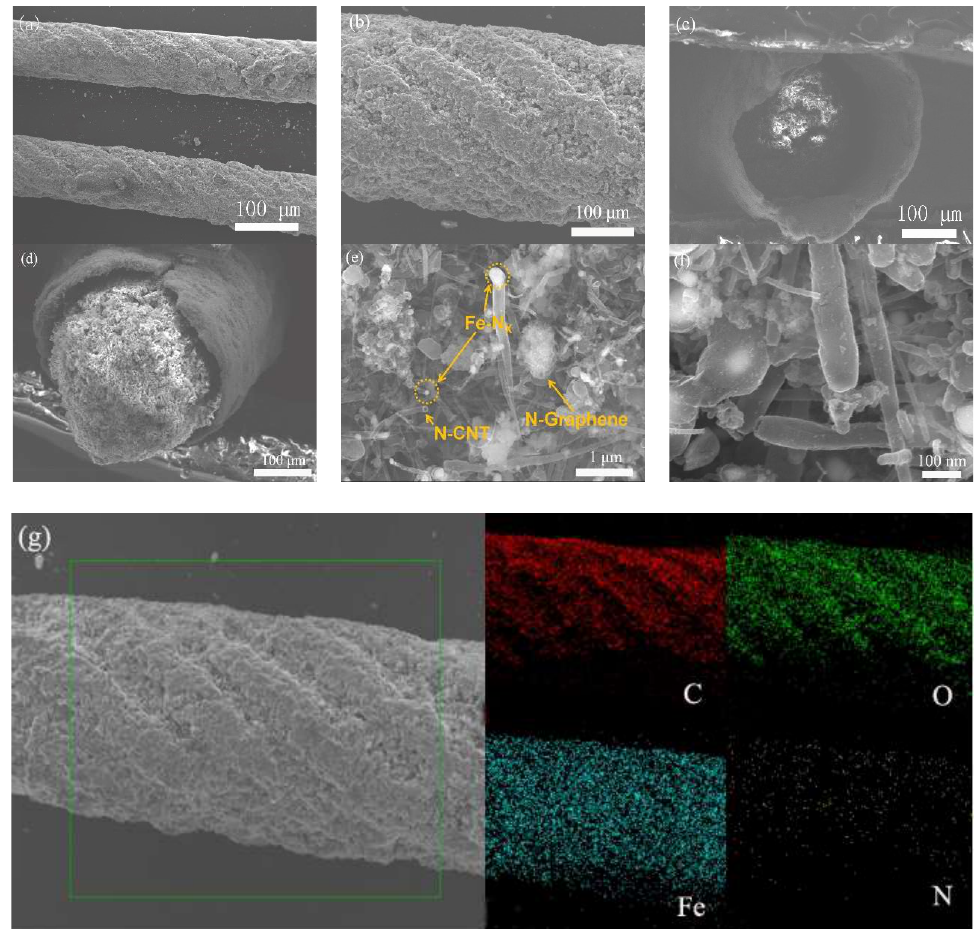
Figure 1. ( a , b ) SEM images of Macroscopic Fe-N x -GNT-2-1000. ( c ) HRTEM image of Fe-N x -GNT-2-1000. ( d ) SEM image of Fe-N x -GNT-1000. ( e , f ) SEM images of Fe-N x -GNT-2-1000. ( g ) Elemental mappings of Fe-N x -GNT-2-1000 showing the uniform distribution of C, O, N and Fe elements in the green frame area.